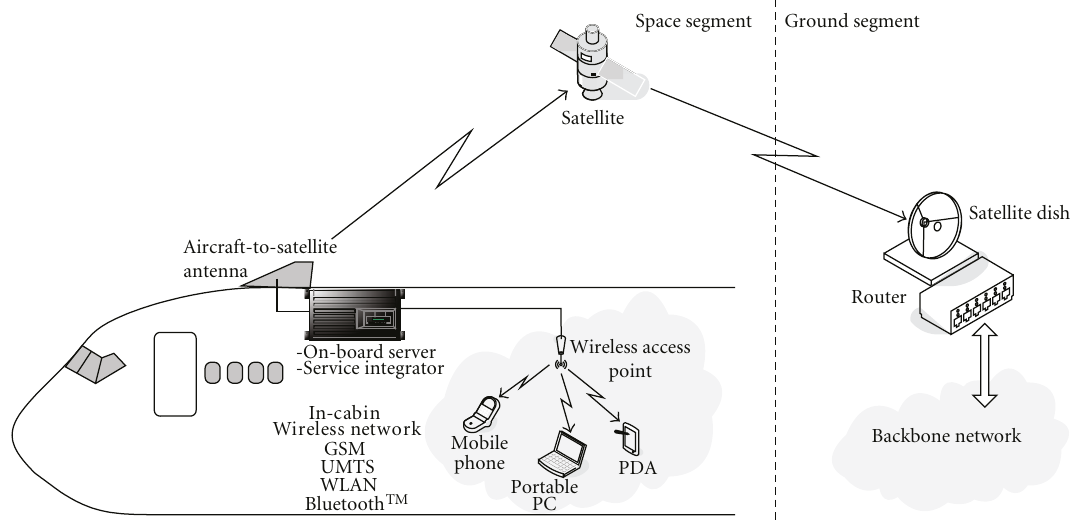
Figure 1: In-cabin wireless network